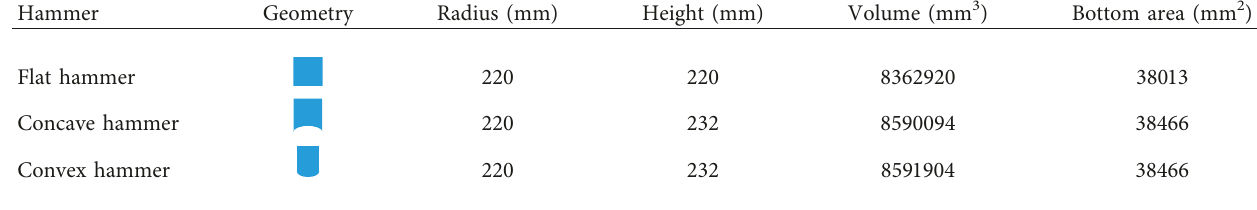
Table 2: Shape of hammers.